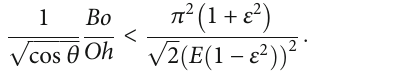
Figure 1: Maximum ð 1/